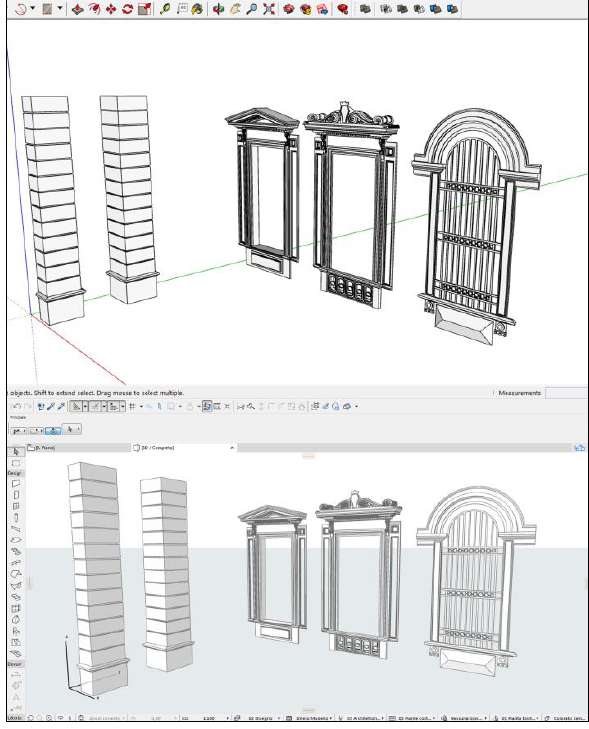
Figure 7 Customized 3D elements in SketchUP software (top), and in ArchiCAD. (bottom)